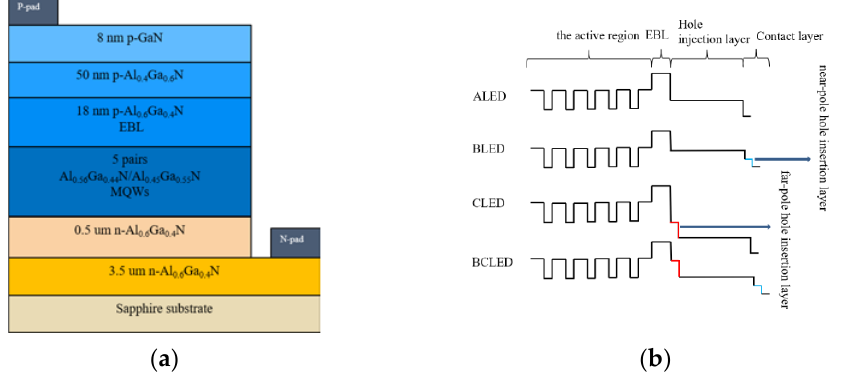
Figure 1. ( a ) Schematic diagram of traditional structure ALED. ( b ) Schematic conduction band pro- files of the four structures (ALED, BLED, CLED, BCLED).